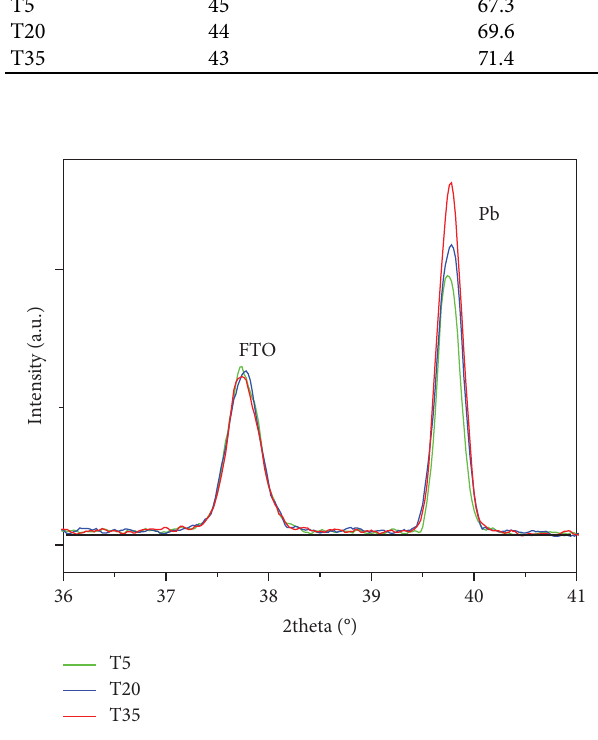
Figure 8: Characteristic peak positions of FTO and lead in the 2 θ range 36 ° − 41 ° of samples obtained at 5, 20, and 35 °